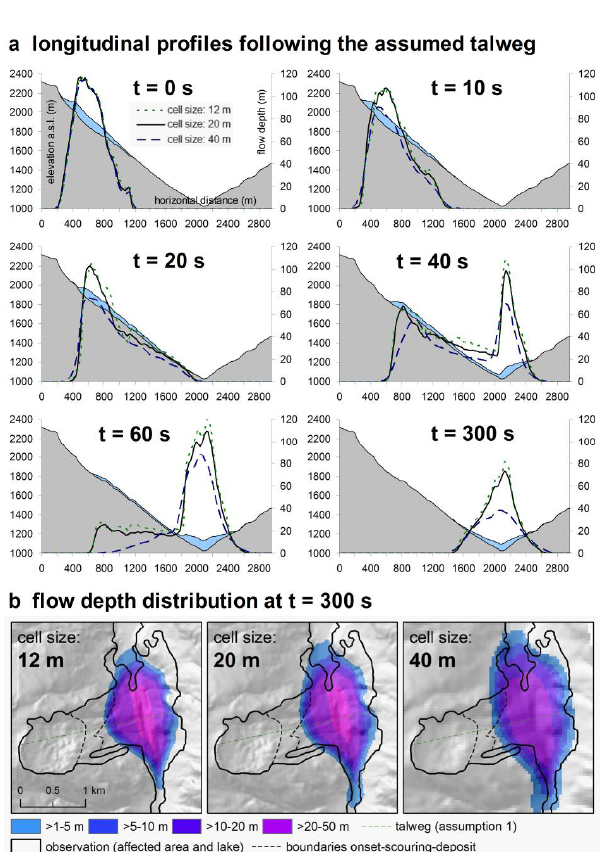
Fig. 8: (a) Longitudinal profiles of the flow along the talweg at different time steps with φ = 35° and δ = 22°: comparison of the results for 12 m, 20 m and 40 m cell size – the result for 20 m is also shown proportionally to the terrain; (b) flow depth distribution after t = 300 s, computed at three different cell sizes.